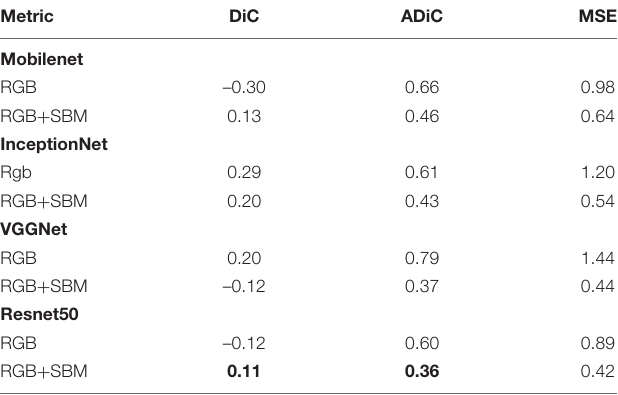
Frontiers in Plant Science |